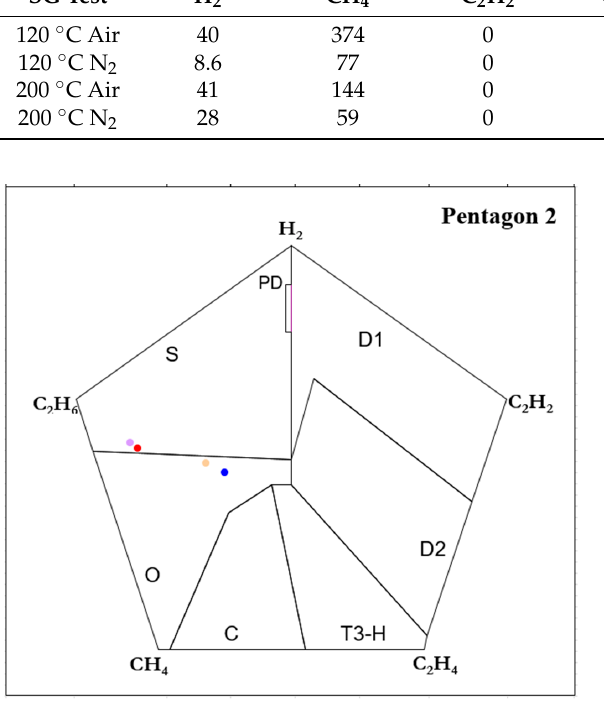
Table 1. SG patterns of DDB oil during SG tests at 120 °C and 200 °C in the laboratory. SG Test